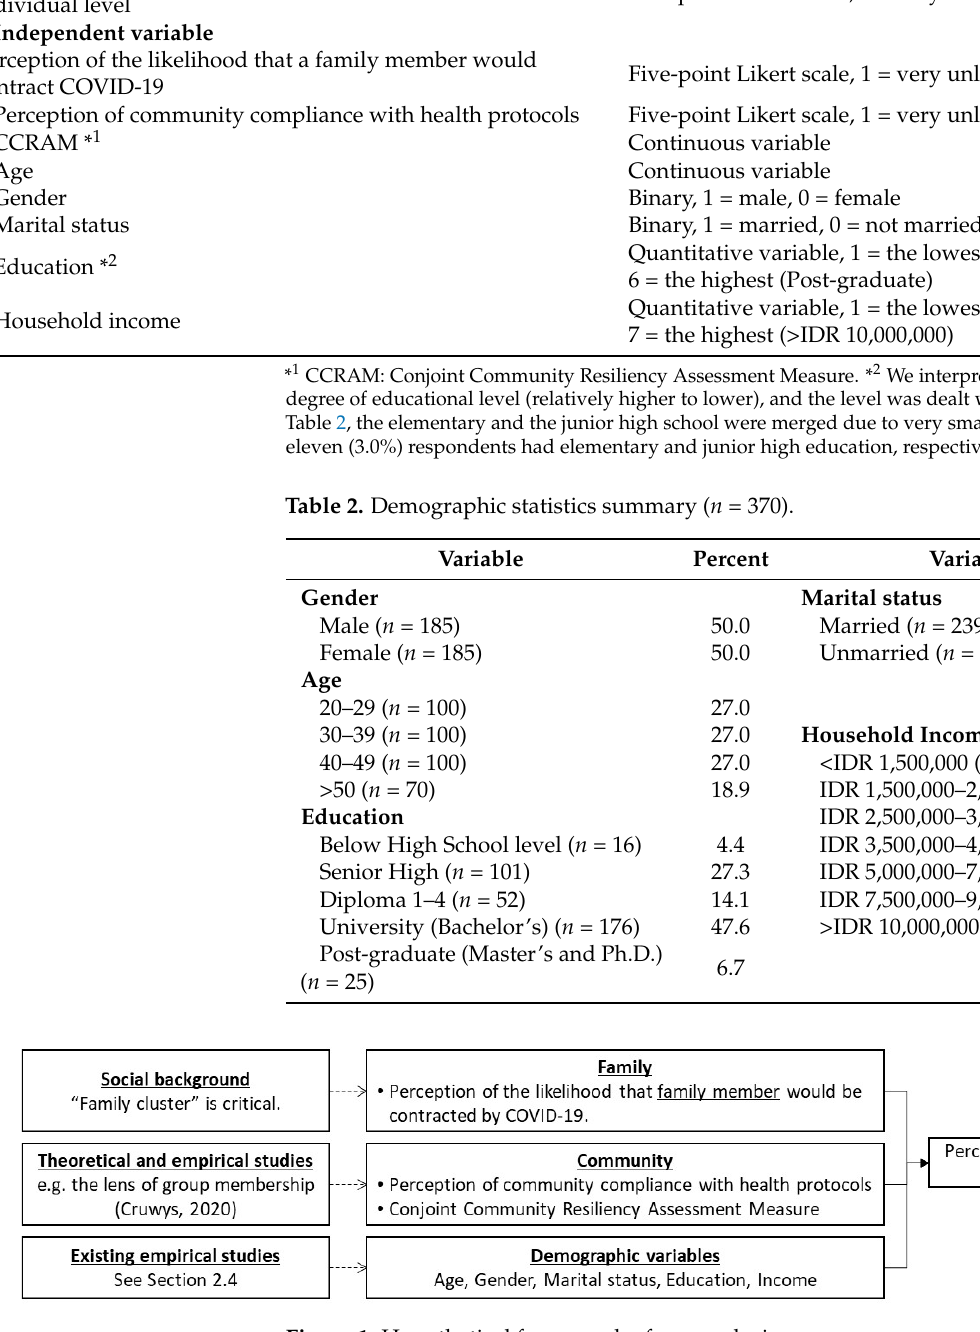
Figure 1. Hypothetical framework of our analysis.